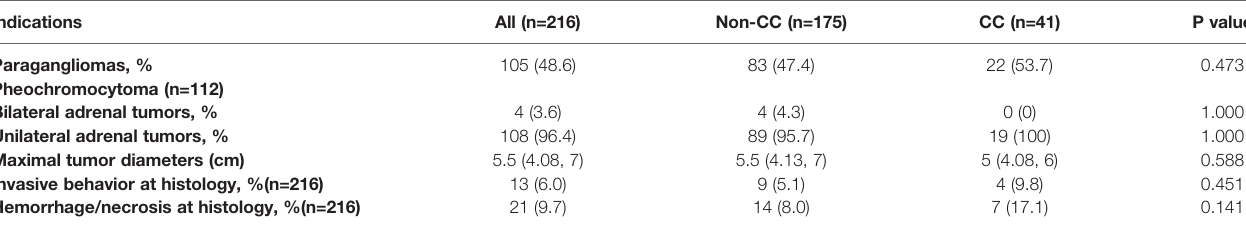
TABLE 3 | Tumor characteristics of patients diagnosed with PPGLs and comparisons between the non-CC and CC groups. Indications All (n=216) Paragangliomas, %